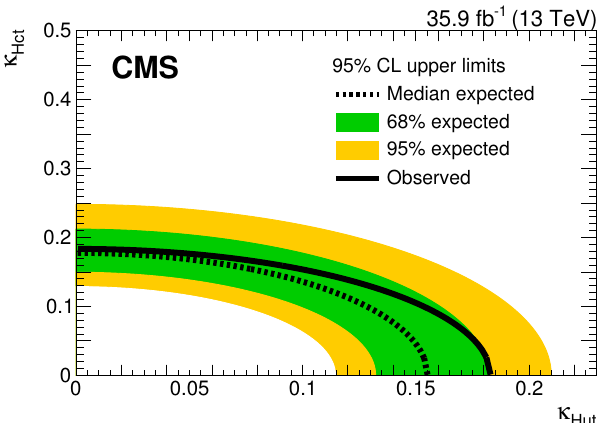
Figure 7 . Upper limits on (cid:20) Hut and (cid:20) Hct at 95% CL.